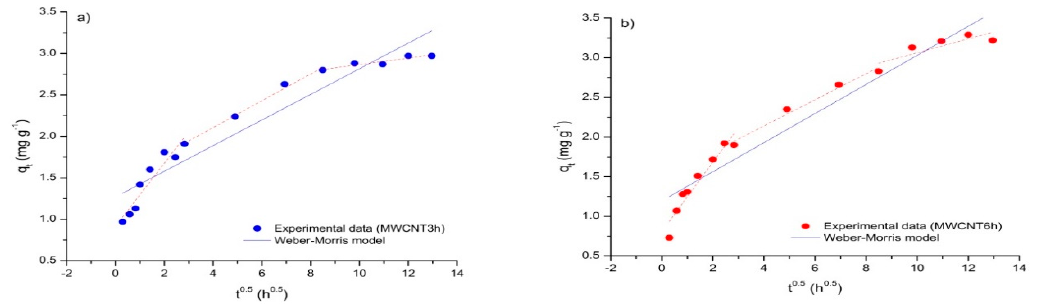
Figure 5. Linear regressions of experimental kinetics data, obtained using the intra-particle diffusion model for Cr(VI) adsorption on: ( a ) oxMWCNT3h and ( b ) oxMWCNT6h.